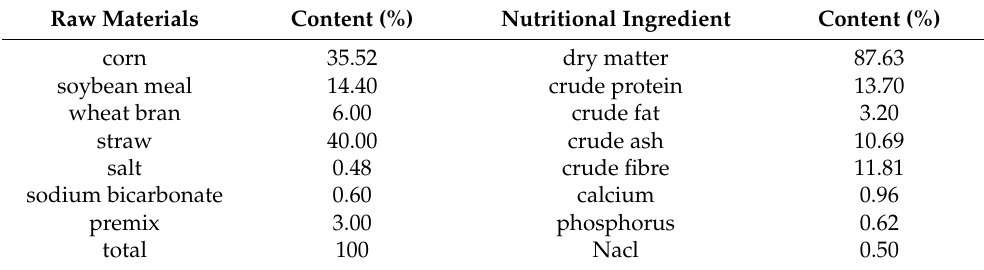
Table 2. Composition and nutritional level of total mixed rations (TMR) diet (dry matter